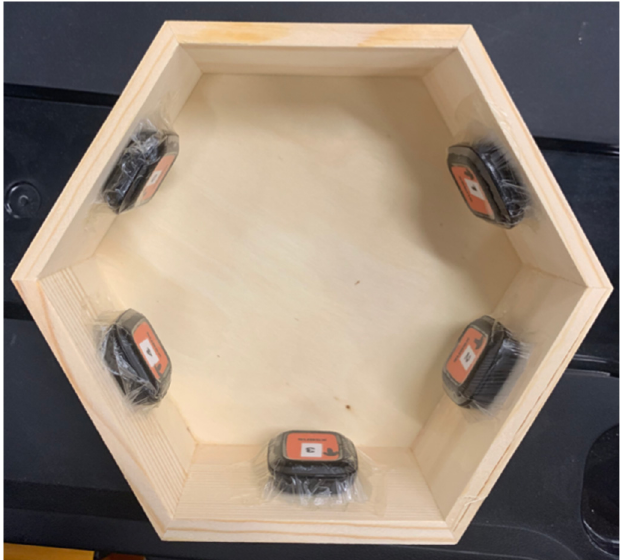
Figure 2. Apparatus for testing of drift under dynamic conditions.